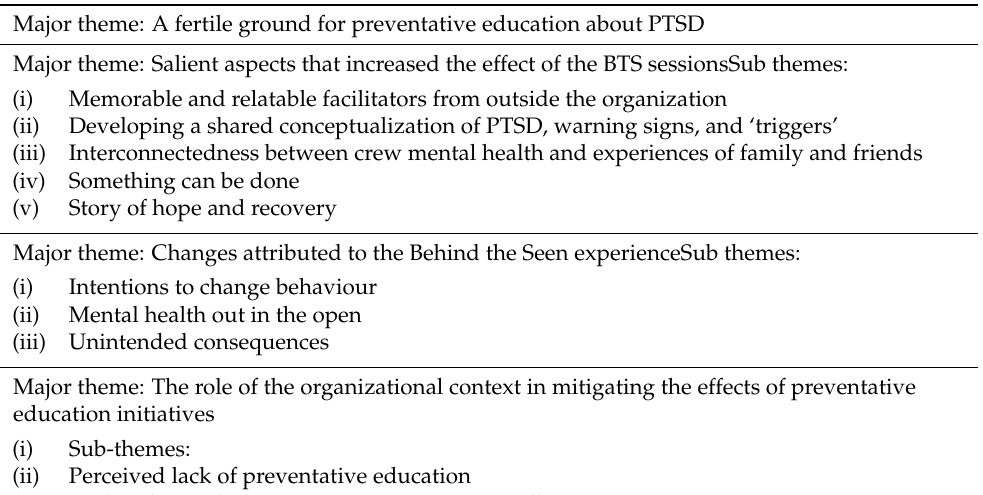
Table 1. Themes and